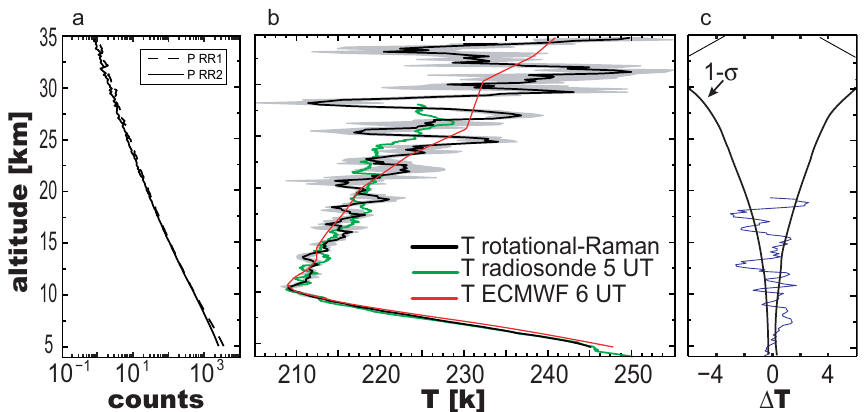
Fig. 3. Temperature measurements at Esrange between 03:17 and 07:58UT on 20 January 2011. (a) Raw counts of the two rotational-Raman channels. (b) Atmospheric temperature profile calculated from the rotational-Raman signal (black, gray area shows the error) in comparison to the temperature profile from a radiosonde launched at 05:00UT from Esrange (green) and the ECMWF-reanalysis temperature profile (red) from 06:00UT. (c) Deviation between the lidar profile and the radiosonde (blue) as well as the statistical temperature uncertainties of the lidar measurements